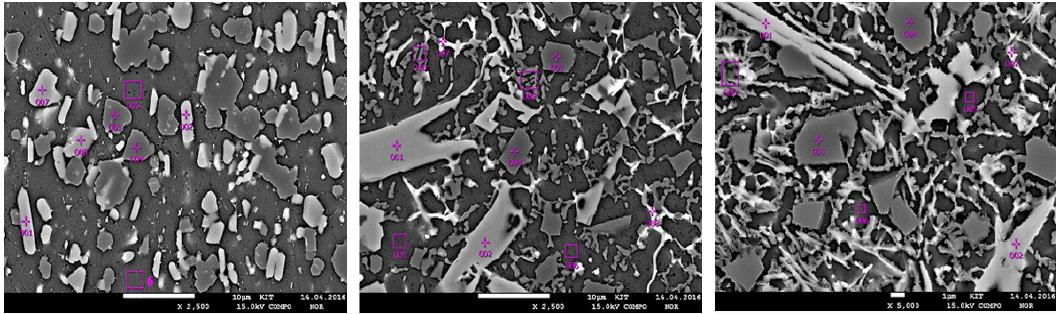
Figure 9. EDX investigation of phases in S232: Left : base material; Middle : welding speed 0.5 m/min; Right : welding speed 10 m/min.